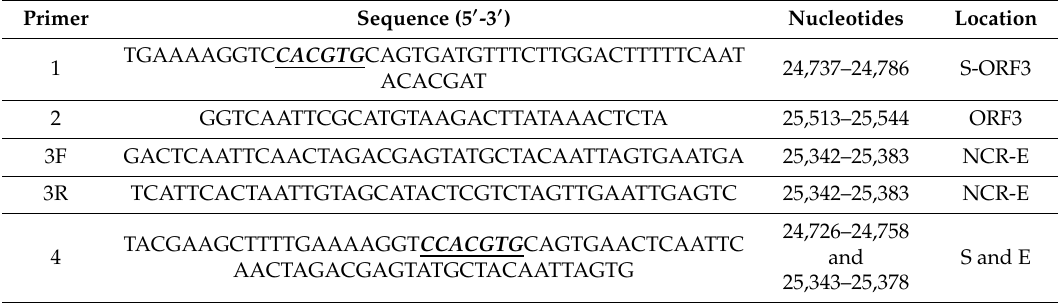
Table 1. Primers used for plasmid constructions and recombinant porcine epidemic diarrhea virus (rPEDV)